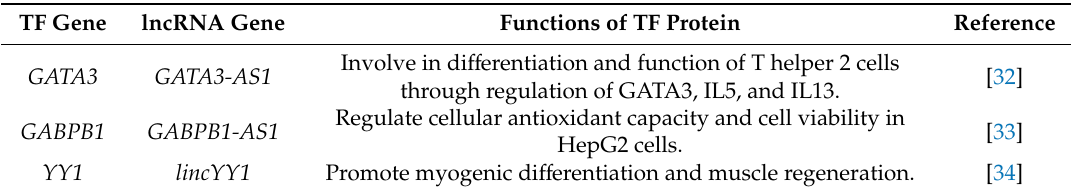
Table 1. Summary of TF-neighborhood lncRNA pairs.